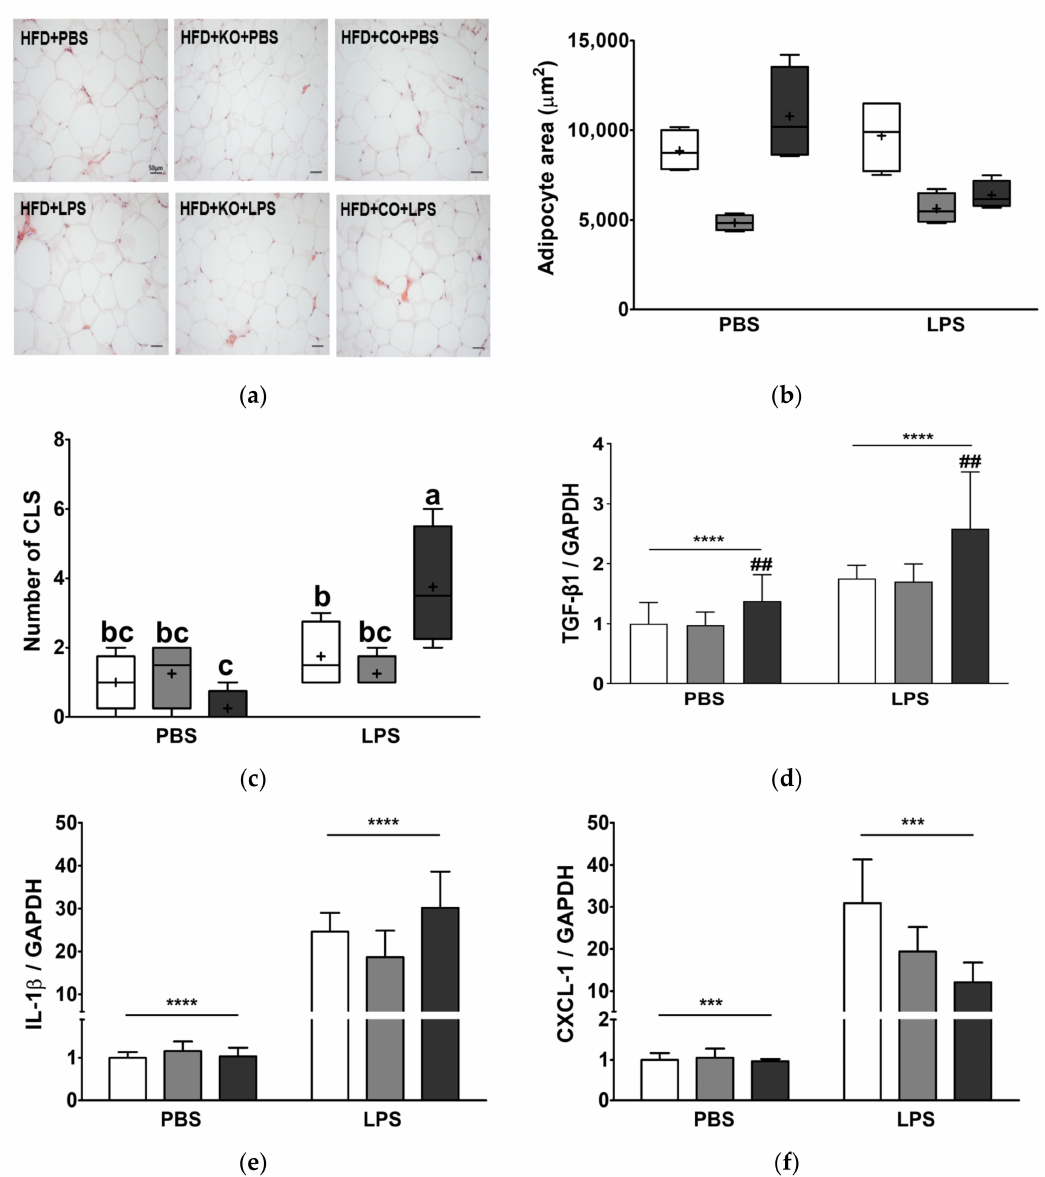
Figure 8. Effects of partial replacement of dietary fat with krill oil or coconut oil on the adipocyte histopathology and mRNA expression of proinflammatory genes in epididymal adipose tissues (EAT) of rats after the LPS challenge. Sprague Dawley rats were fed either a high-fat diet (HFD), HFD partially replaced with krill oil (HFD + KO), or coconut oil (HFD + CO) for 10 weeks, and then treated with PBS or LPS (1 mg/kg) for 24 h. ( a ) Hematoxylin and eosin (H&E) staining of EAT (bar = 50 µ m, 20 × magnification), ( b ) adipocyte area from each group, ( c ) number of crown-like structures (CLS), ( d ) transforming growth factor- β 1 (TGF- β 1), ( e ) interleukin 1 beta (IL-1 β ) level, and ( f ) chemokine (C-X-C motif) ligand 1 (CXCL-1) levels were measured. Values are displayed as box-and-whisker plots, n = 8 for individual group. Data were analyzed by two-way ANOVA followed by Tukey’s multiple comparisons test to determine the interactions or the main effects (diet and LPS stimulation). Asterisk indicates a significant main effect for LPS (*** p < 0.001, **** p < 0.0001). Pound indicates a significant main effect for diet ( ## p < 0.01). Labeled means without a common letter differ significantly, p < 0.05. The mean values are indicated by “+” signs. HFD, high-fat diet; HFD + KO, high-fat diet + krill oil; HFD + CO, high-fat diet + coconut oil; PBS, phosphate-buffered saline; LPS,